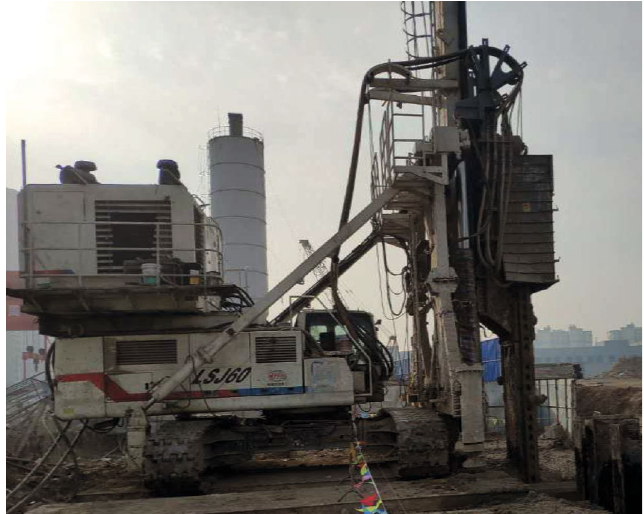
Figure 2: TRD machine in working.